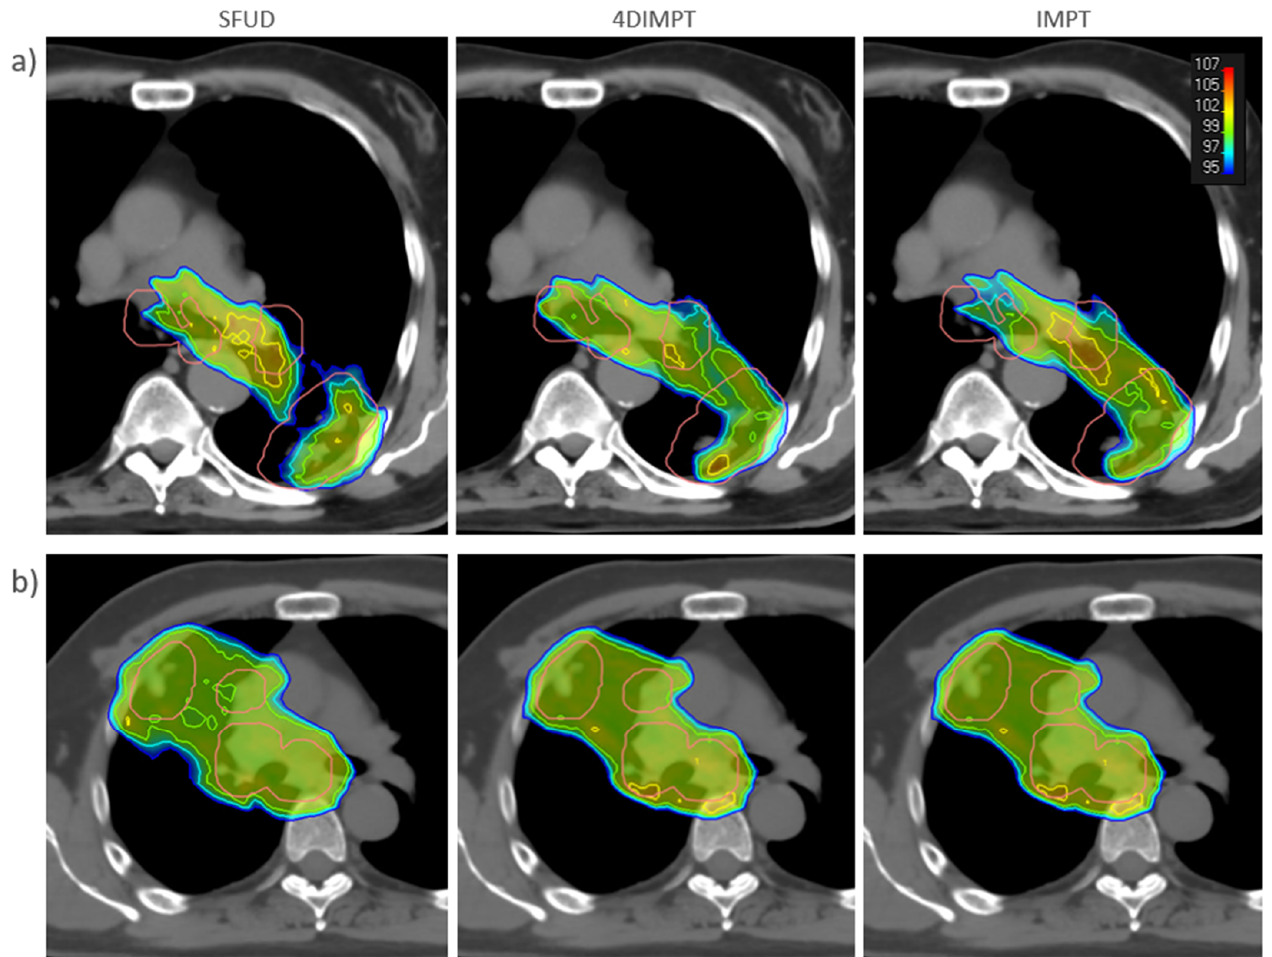
Figure A3. SFUD ( left ), 4DIMPT ( middle ), and IMPT ( right ) plans recalculated on the Start AIP for ( a ) one of the patients that failed the robustness criteria (patient 11) and ( b ) one of the patients with satisfactory target coverage (patient 10). The CTV is delineated in pink. Doses higher than 95% of the prescribed dose are shown, according to the color scale in the top right corner.